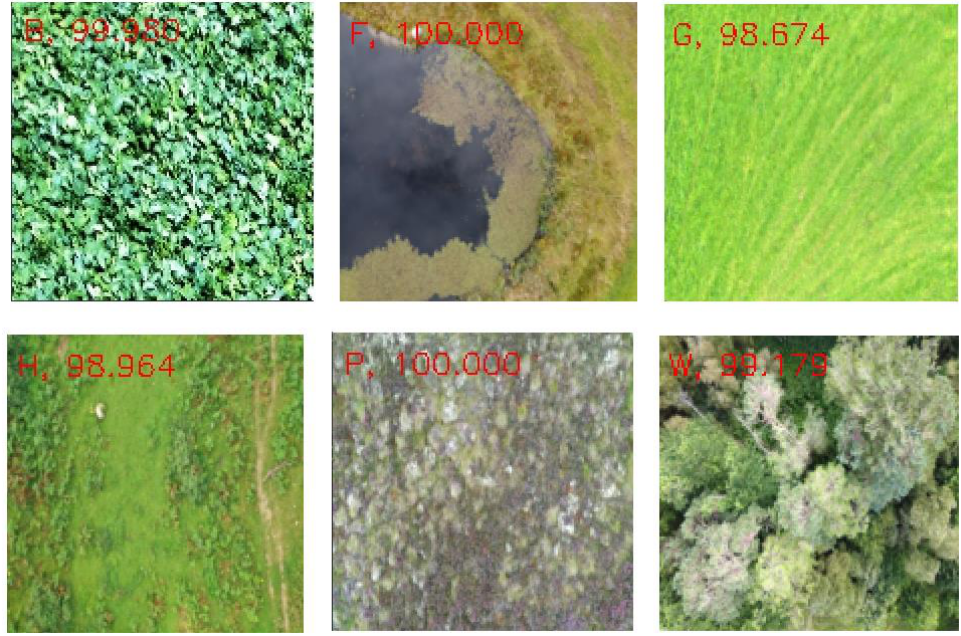
Figure 17. Classification accuracy (%) of sample images .